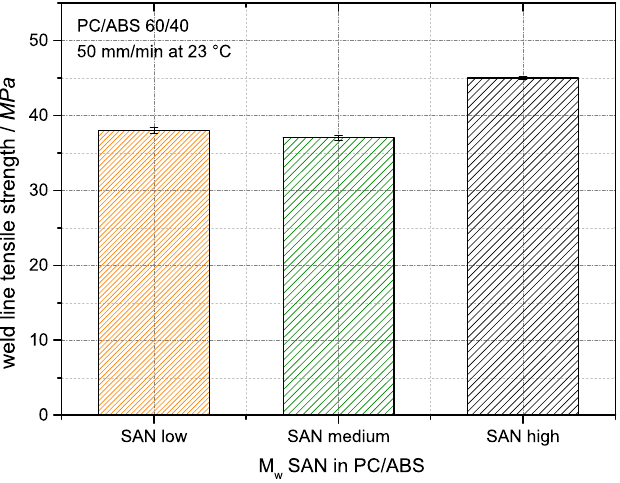
Figure 16. Effect of SAN molecular weight on the weld line tensile strength of PC/ABS blends at 23 °C.